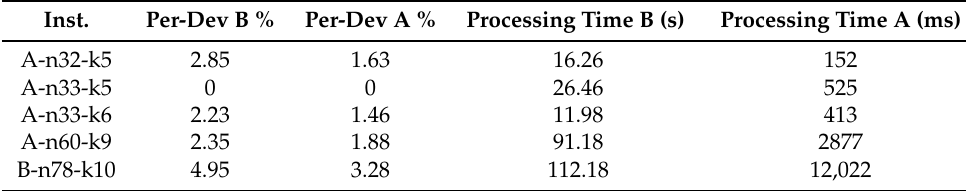
Table 5. The obtained co-simulation result of models M 1 with M 2 . Inst.